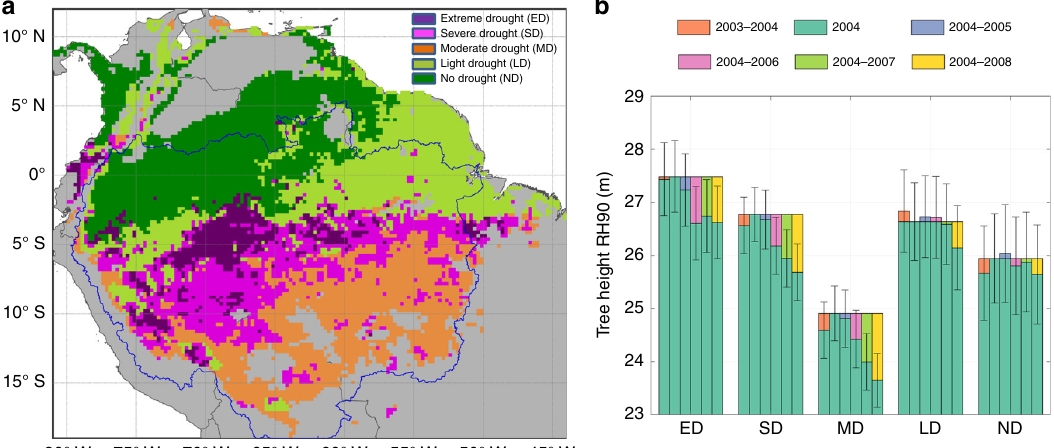
Fig. 1 Spatial patterns of rainfall and corresponding canopy structure changes in each climatic region. a Drought classi fi cation map derived from rainfall data 82 . b Interannual changes of top canopy structure (RH90) relative to RH90 in 2004 for each climatic region de fi ned in panel a . The abbreviations ED, SD, MD, LD, and ND are regions of extreme drought, severe drought, moderate drought, light drought, and no drought. The purple line in panel a delineates the boundary of Amazon basin area. Non-tropical forests in panel a were colored in gray. The error bars in panel b stand for 95% con fi dence intervals. Estimations in panel b were derived from the spatial modeling with fi lled data gaps (SMF) method (see